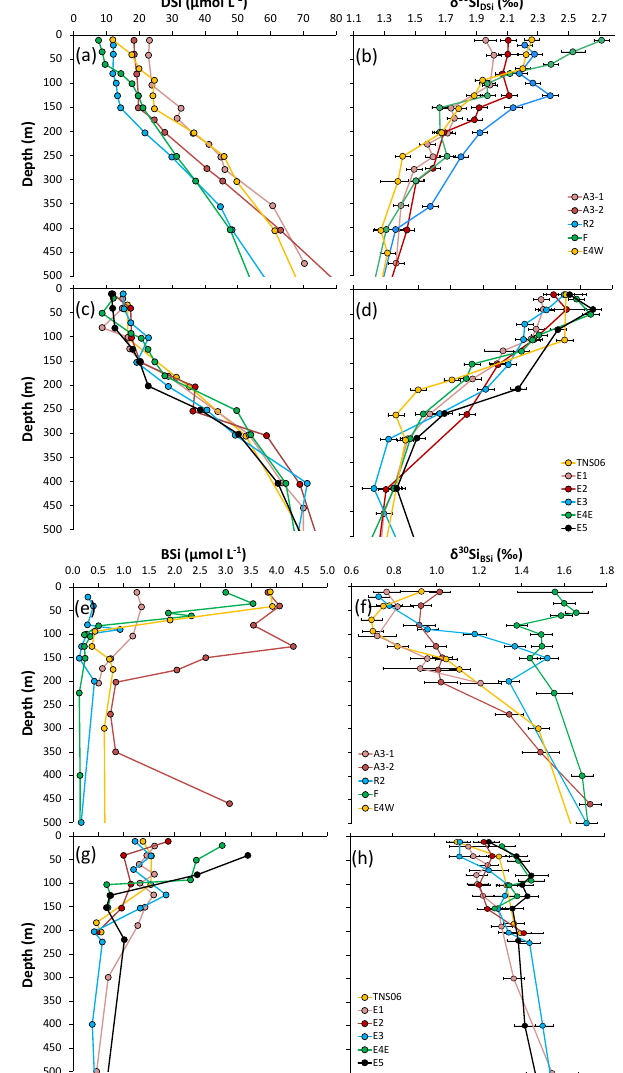
Figure 2. Vertical profiles of biogenic silica and silicic acid con- centration (µmolL − 1 ) and isotopic composition (‰) of dissolved (panels a to d ) and particulate silicon (panel e to h ) for the main contrasted KEOPS-2 stations (A3, R2, E4W and F-L) and for the meander stations (TNS6, E1, E2, E3, E4E and